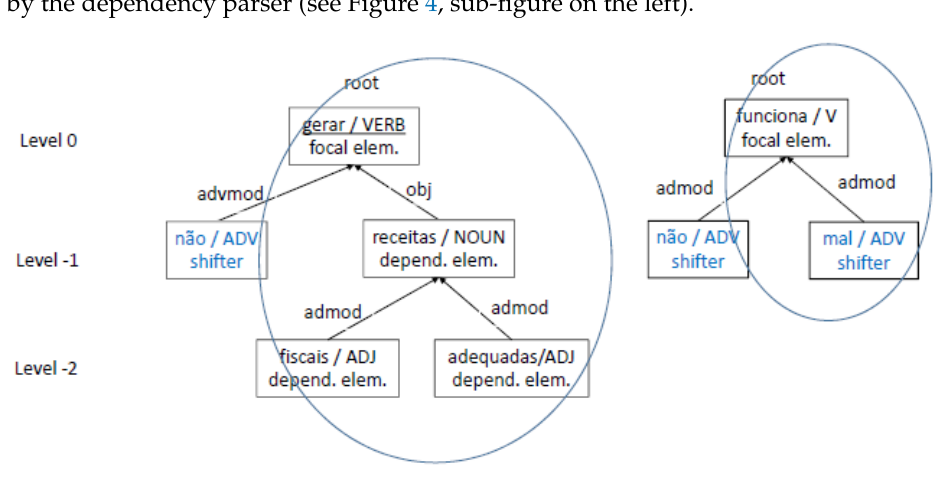
Figure 4. Example of tokens linked by